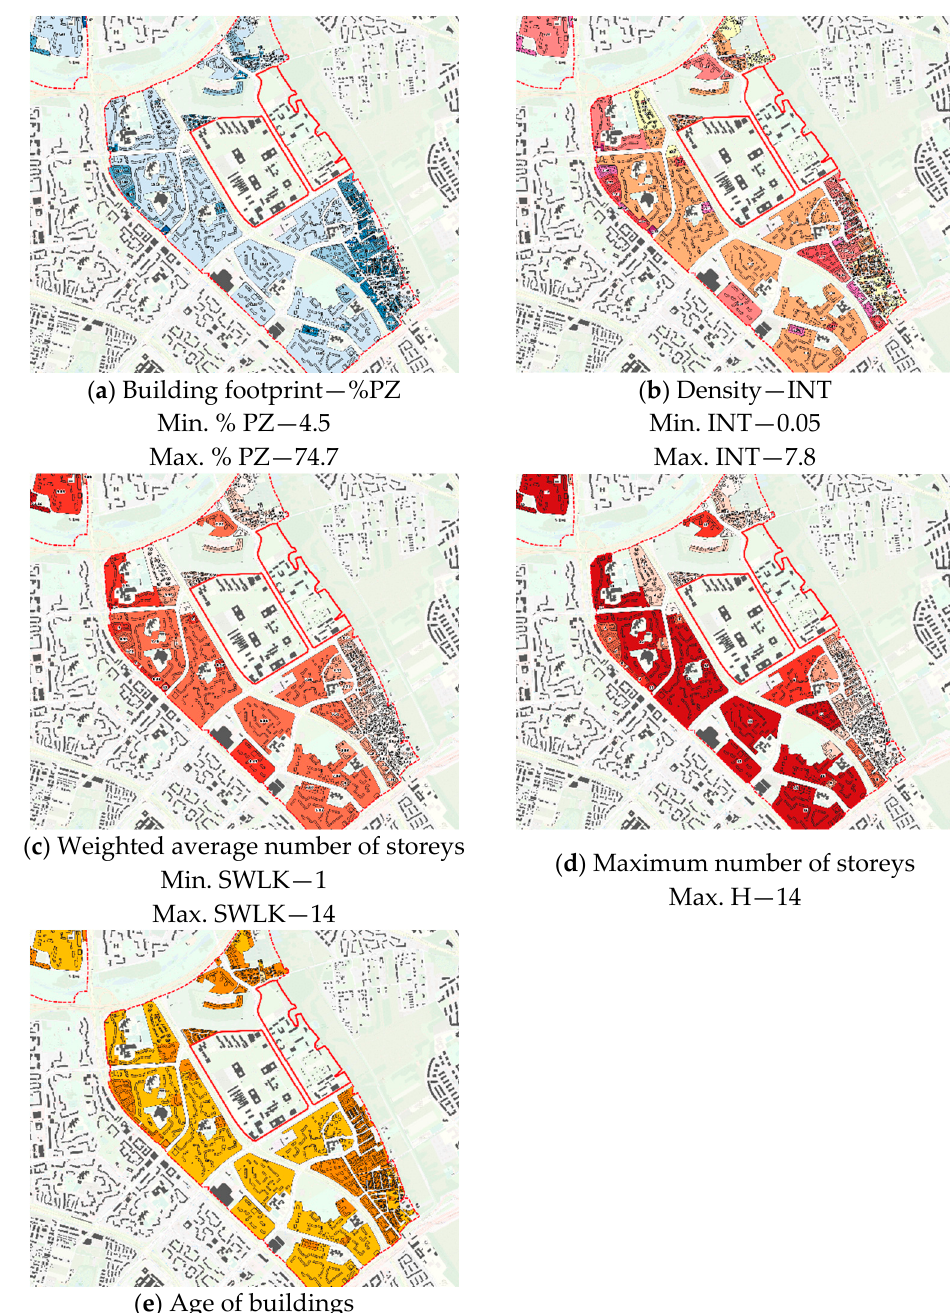
Figure 10. Spatial distribution of urban indicators for the area of analysis. Source: own study.